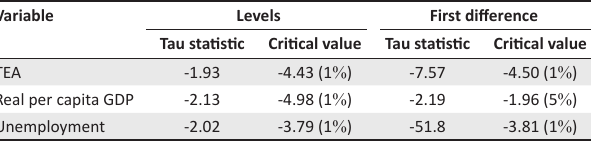
FIGURE 3: Graph of total entrepreneurship activity and real per capita gross domestic product. TABLE 1: Unit root